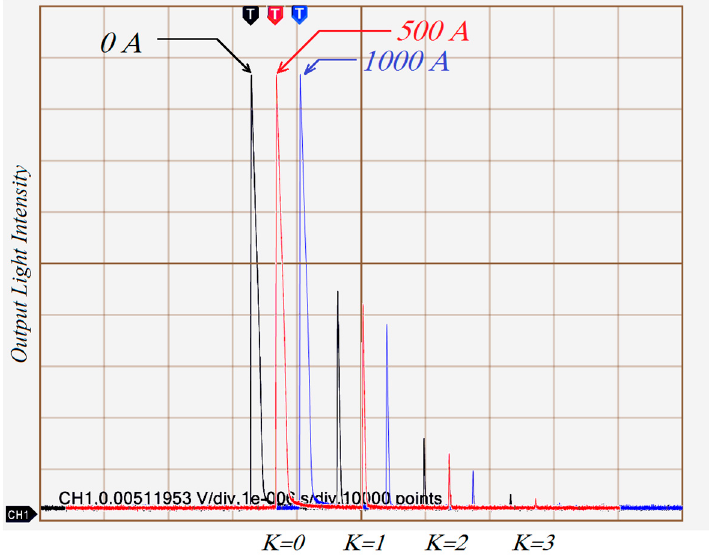
Figure 3. Intensity variations of output light for currents of 0 A, 500 A, and 1000 A passing through the sensor head. Measurements were carried out with a Tektronix TDS3054B 500 digital oscilloscope.